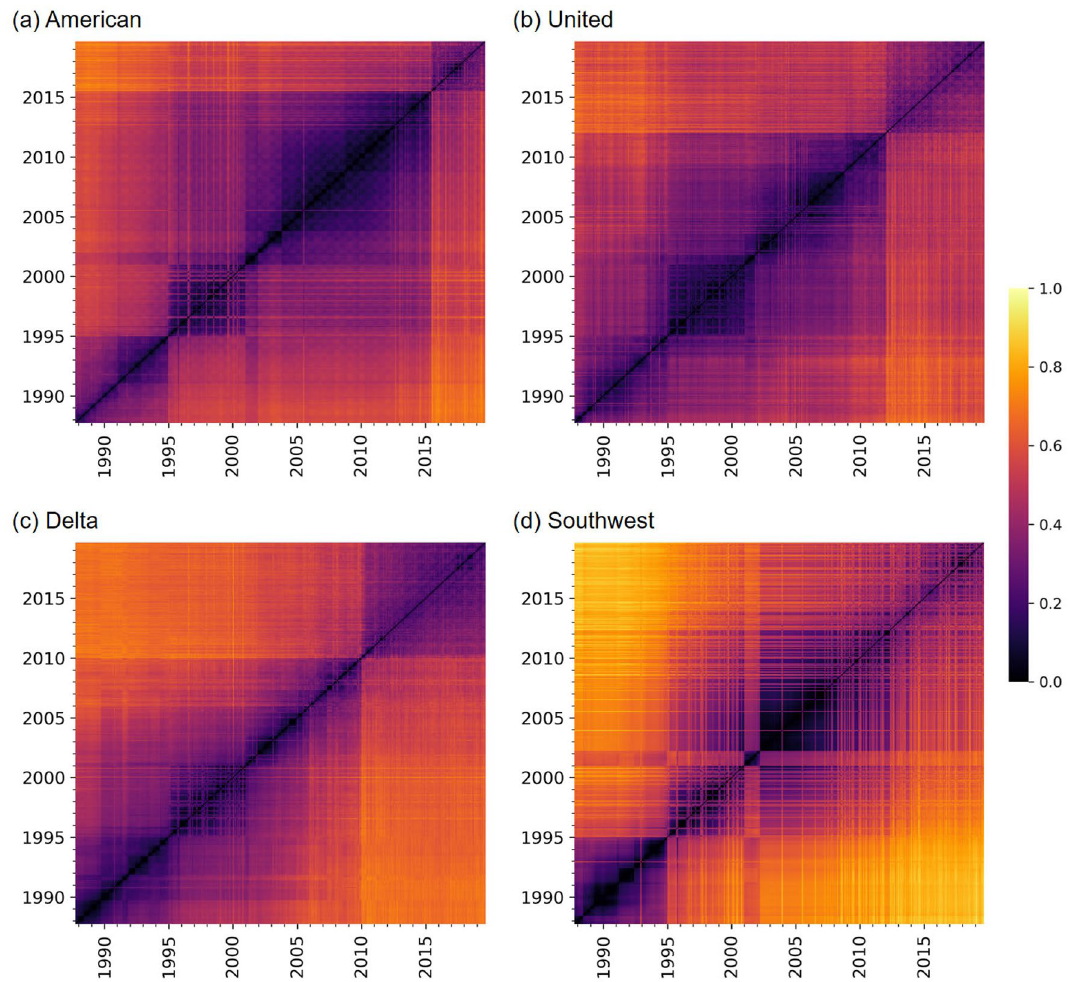
Figure 2. Network-distance matrices. ( a ) American Airlines, ( b ) United Airlines, ( c ) Delta Air Lines, and ( d ) Southwest Airlines. Effect size,